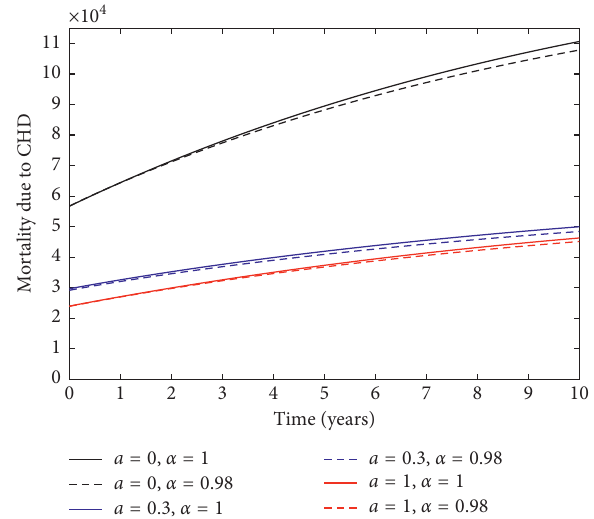
Figure 2: Mortality due to CHD, where a � 0 , 0 . 3 , 1 with different values of α (in the absence of u